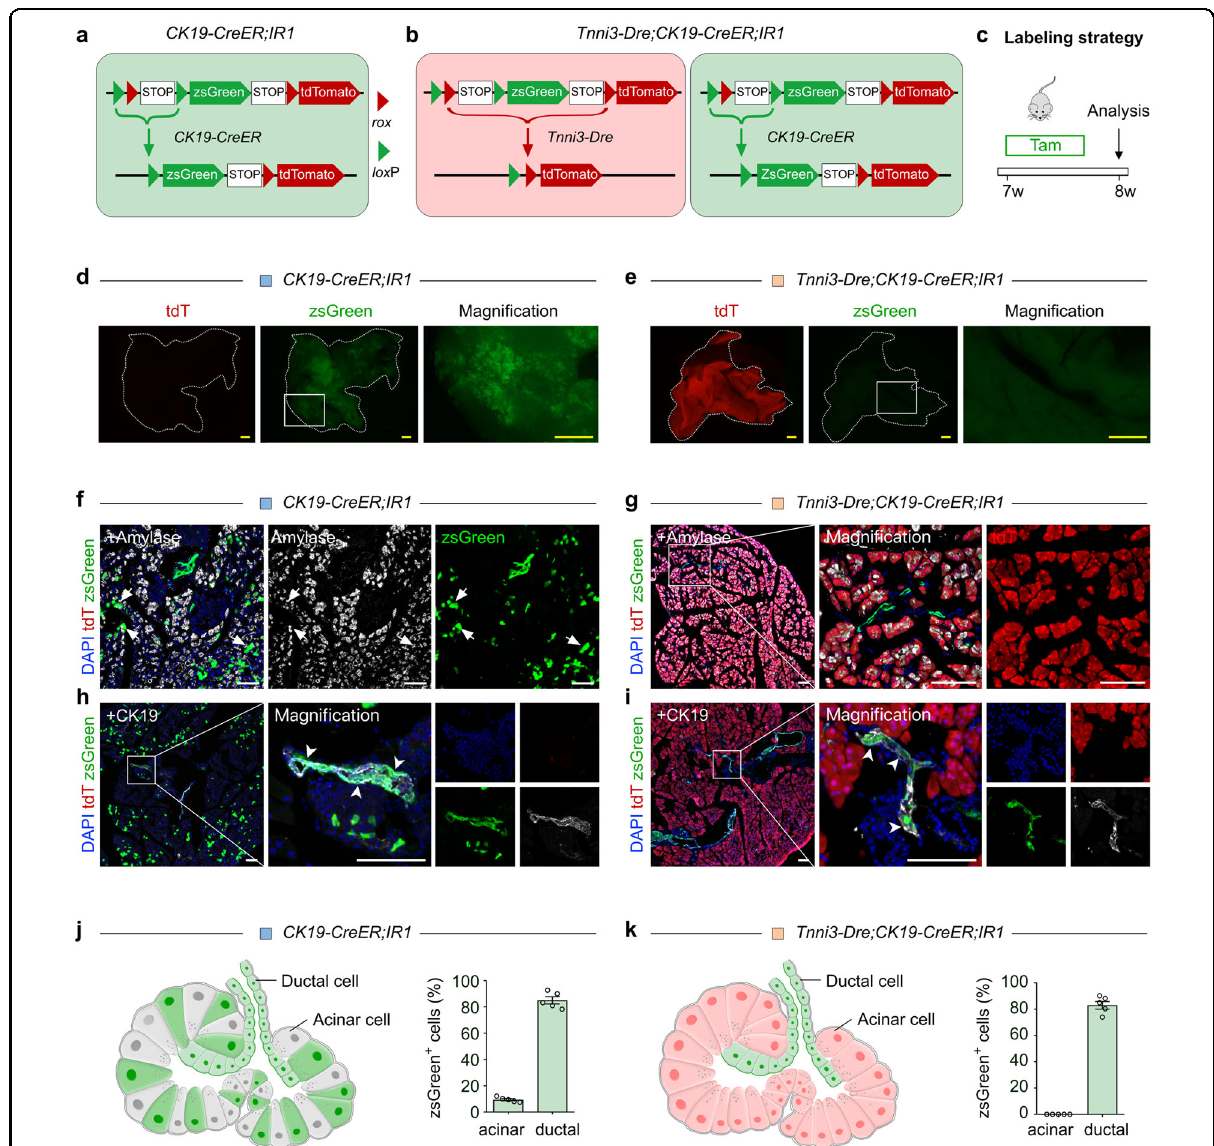
Fig. 1 Genetic labeling of pancreatic exocrine ductal and acinar cells by a Tnni3-Dre;CK19-CreER;IR1 strategy. a Schematic diagram illustrating the strategy for labeling pancreatic ductal cells by CK19-CreER;IR1 . b Schematic diagram illustrating the strategy for labeling pancreatic ductal and acinar cells by Tnni3-Dre;CK19-CreER;IR1 using a dual recombinase-mediated genetic approach. c Schematic diagram illustrating the experimental strategy for tamoxifen (Tam) induction and analysis. d , e Whole-mount fl uorescent images of pancreas from CK19-CreER;IR1 ( d ) or Tnni3-Dre;CK19- CreER;IR1 ( e ) mice. f – i Immunostaining for tdT, zsGreen and Amylase ( f , g ) or CK19 ( h , i ) on pancreatic sections collected from indicated mice. Arrowheads, zsGreen + ductal cells. Arrows, zsGreen + acinar cells. j , k Schematic diagram illustrating the labeling strategy (left) and quanti fi cation of the percentage of ductal and acinar cells expressing zsGreen (right) by either CK19-CreER;IR1 ( j ) or Tnni3-Dre;CK19-CreER;IR1 ( k ) strategy. Data are means ± SEM; n = 5. Scale bars, yellow, 1 mm; white, 100 μ m. Each image is representative of 5 individual